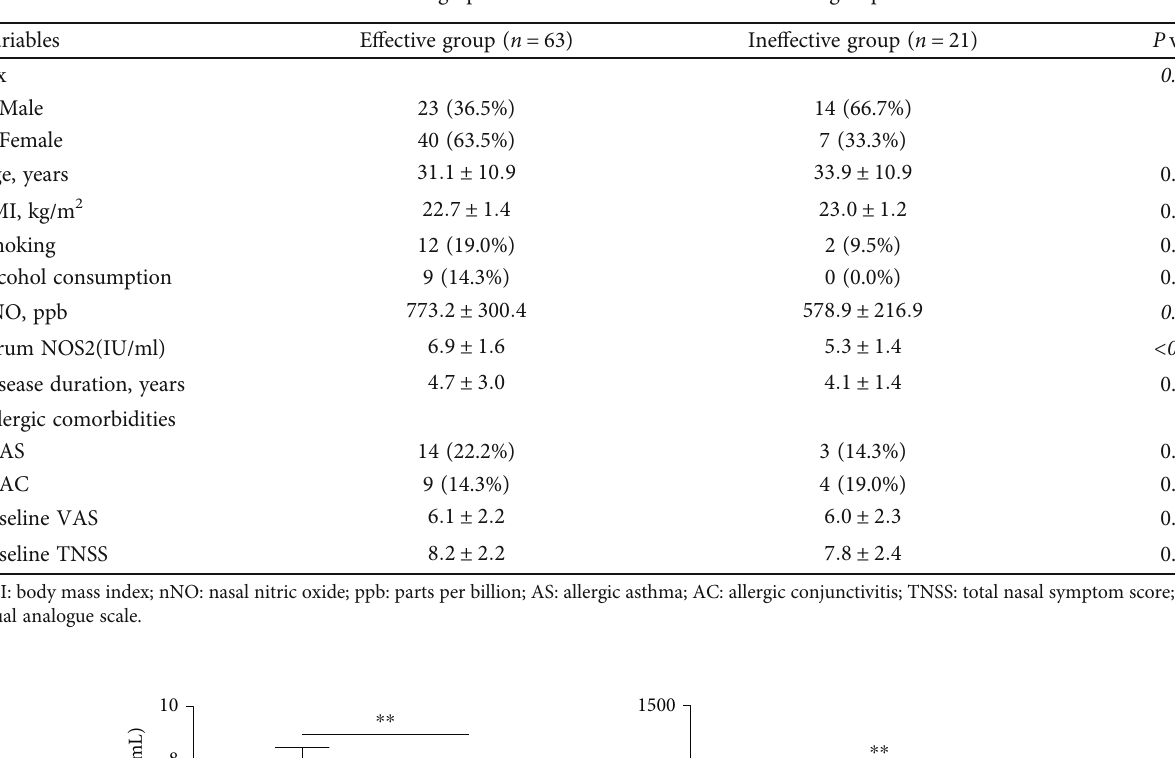
Table 4: Demographics and clinical characteristics of two groups.